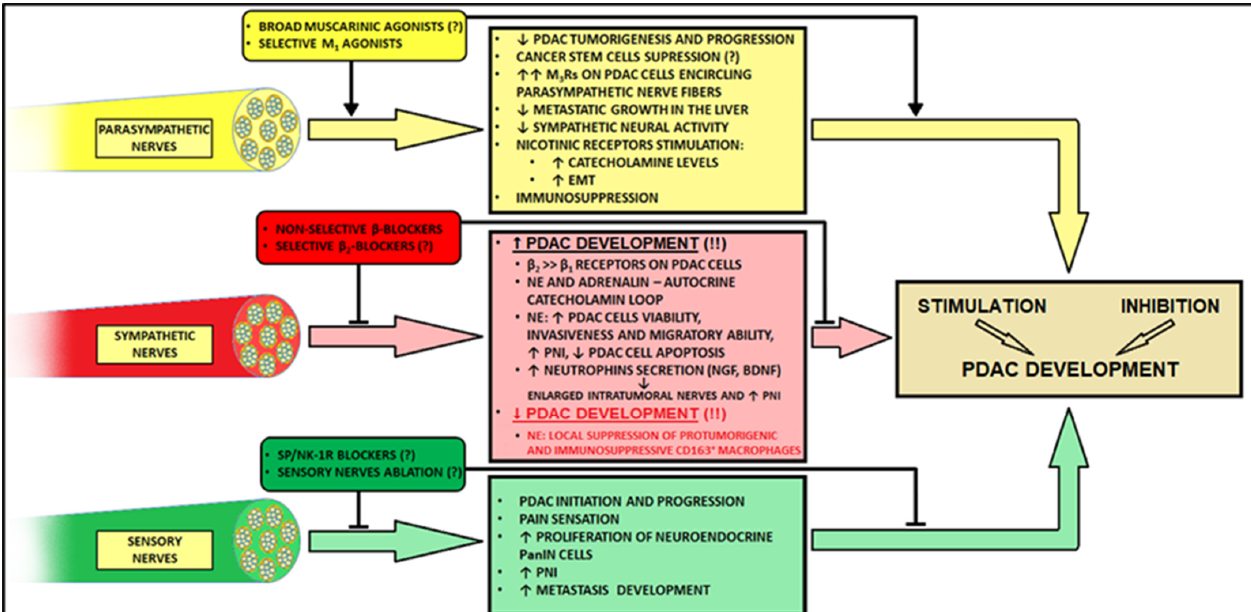
Figure 2. The complexity and impact of the autonomic nervous system on the PDAC tumor microenvironment and possible nerve-oriented treatment modalities. SP/NK-1R, substance-P/neurokinin 1 receptor; PDAC, pancreatic ductal adenocarcinoma; NE, noradrenaline; NGF, nerve growth factor; BDNF, brain-derived neurotrophic factor; PNI, perineural invasion; PanIN, pancreatic intraepithelial neoplasia.